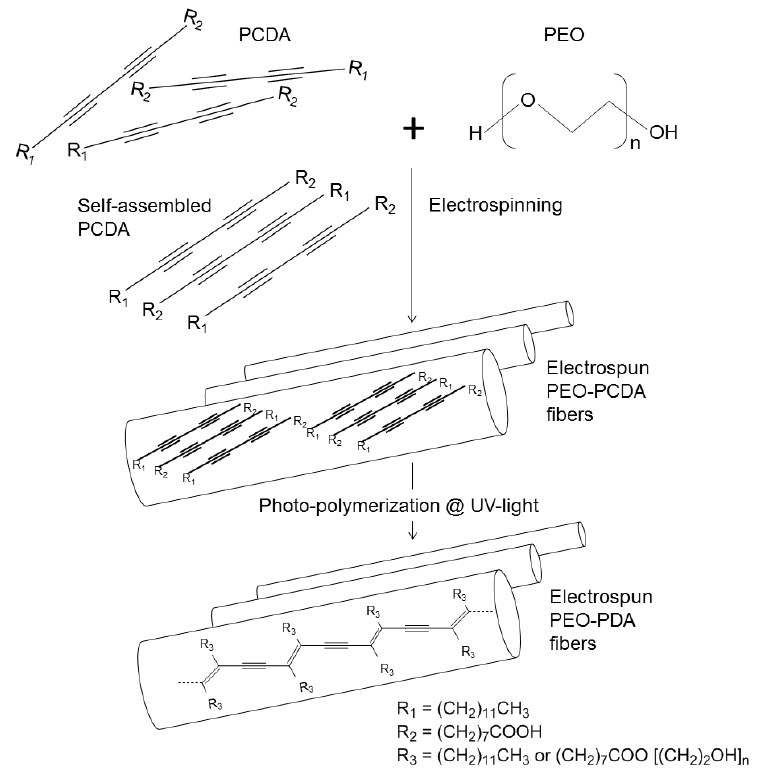
Figure 1. Schematic representation of the electrospinning of poly (ethylene oxide) (PEO) -Polydiacetylene (PDA) composite fibers.